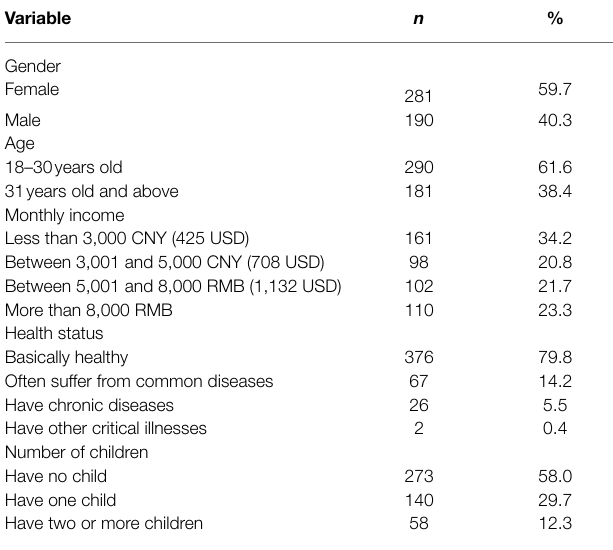
TABLE 1 | Demographic characteristics of participants ( n =